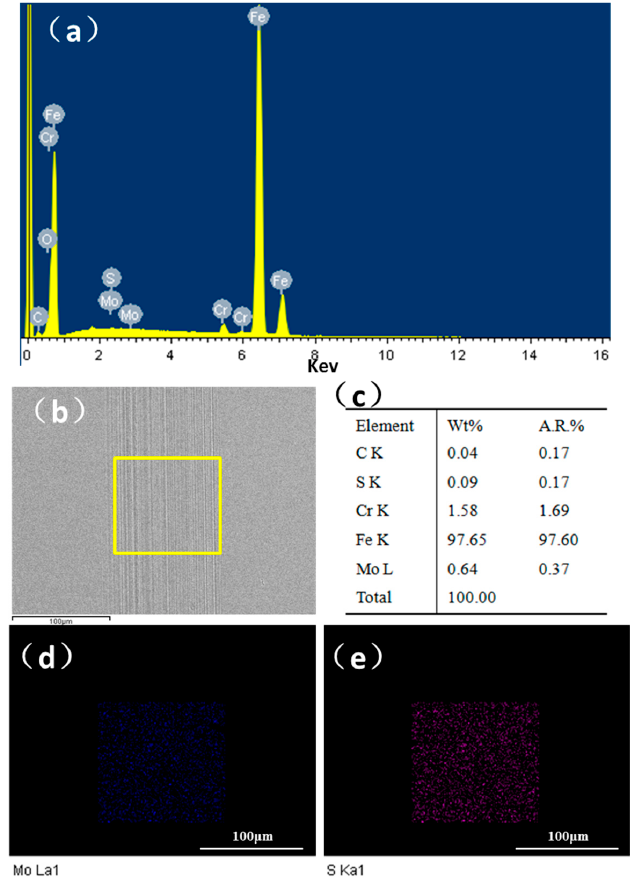
Figure 7. EDS characterization within the wear track: ( a ) EDS pattern of wear track for bottom disc; ( b ) SEM image of wear track; ( c ) EDS report of different elements; ( d ) elemental mapping characterization of Mo on the wear track; ( e ) elemental mapping characterization of S on the wear track.